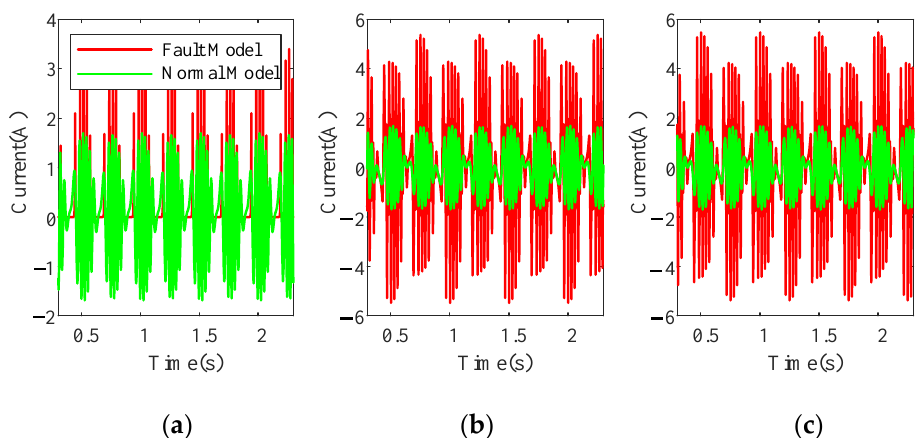
Figure 10. Fault data of A-phase upper-bridge IGBT open circuit. ( a ) A-phase current; ( b ) B-phase current. ( c ) C-phase current.